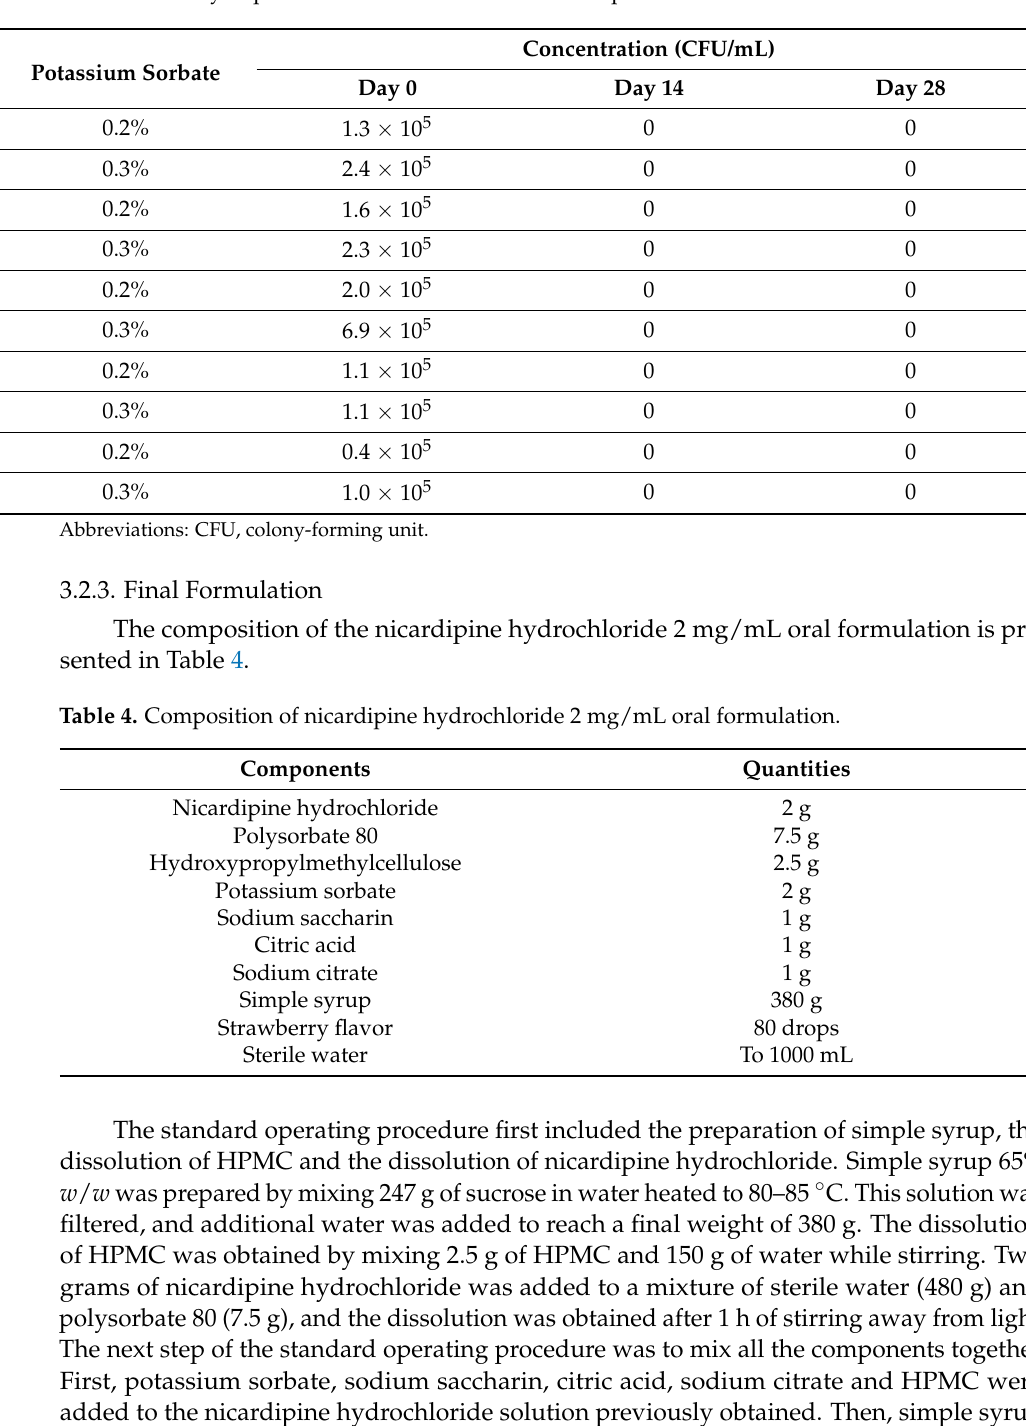
Table 3. Efficacy of potassium sorbate for antimicrobial preservation.